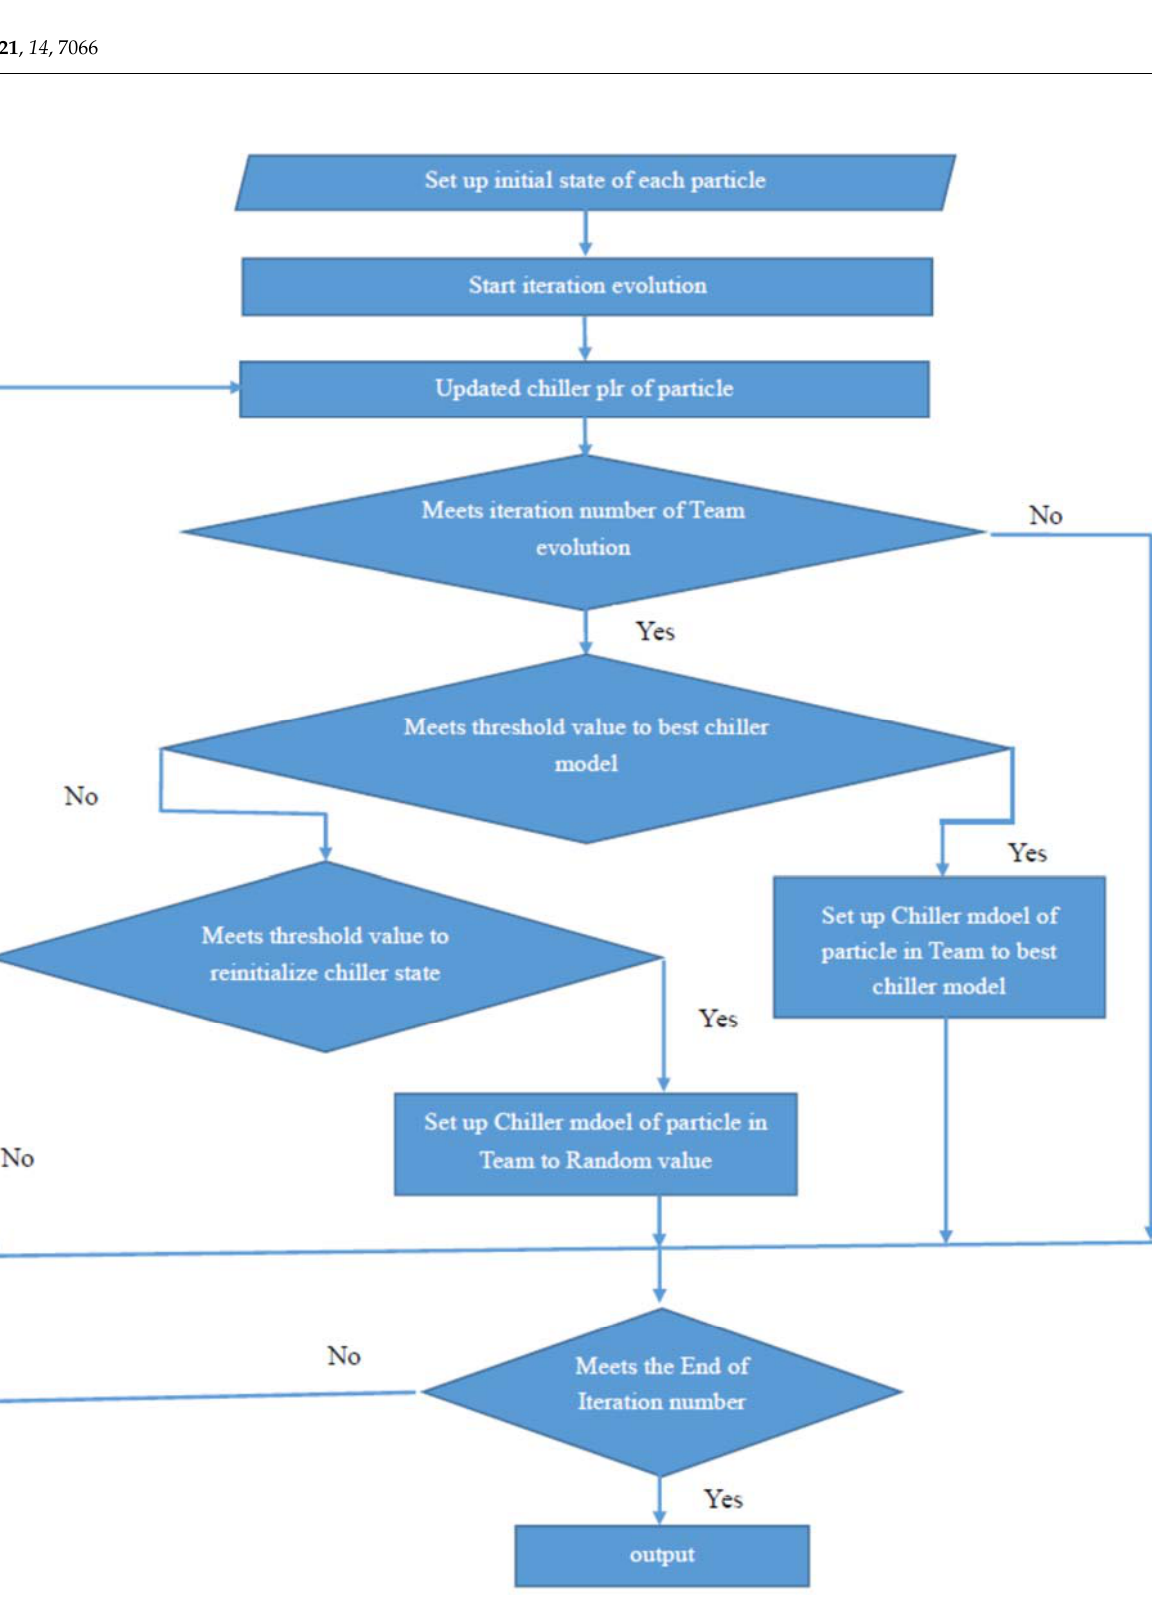
Figure 2. Flow Chart of the TPSO evolution progress.